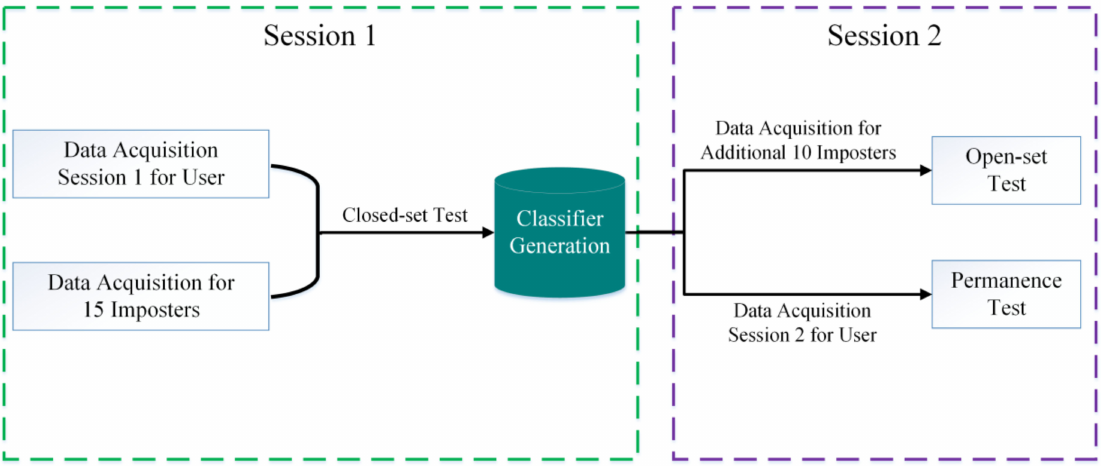
Figure 3. Flowchart of data acquisition and performance test for a